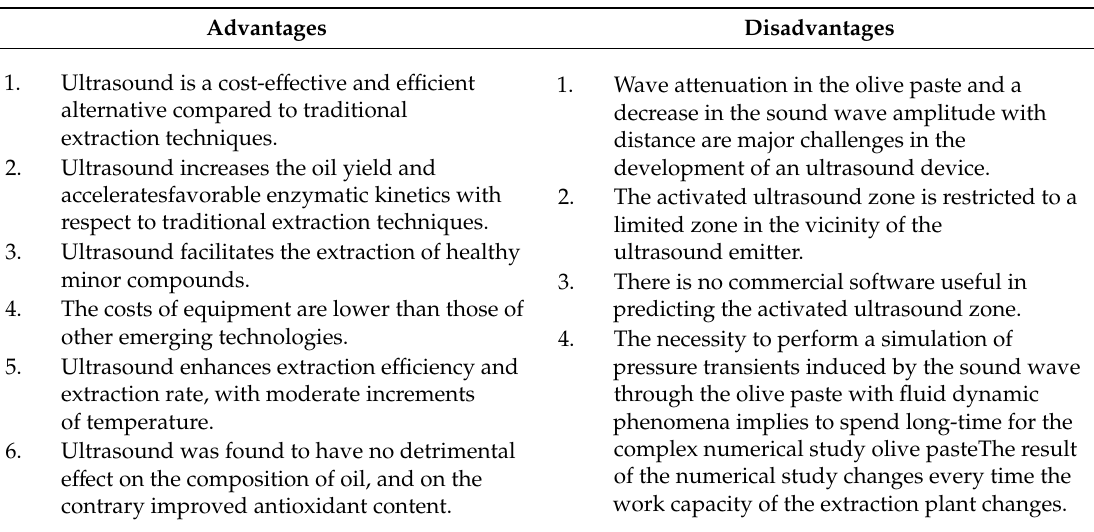
Table 2. Benefits and drawbacks of industrial ultrasound applications in the extra-virgin olive oil extraction